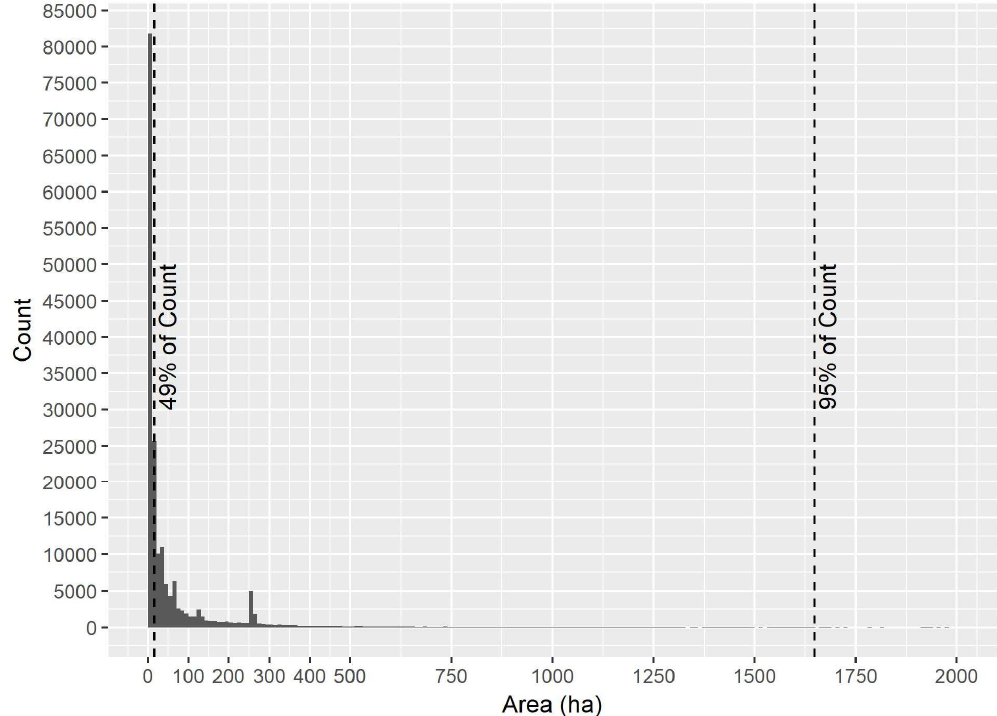
Figure 1. Frequency distribution of protected area parcel sizes in the United States. The x axis is truncated at 2000 ha in order to show the distribution on the y axis without transforming the data. Bin count is 10 ha. Bars represent the percentage of total records smaller than the mean (95%) and median areas (49%). R version 3.4.2.